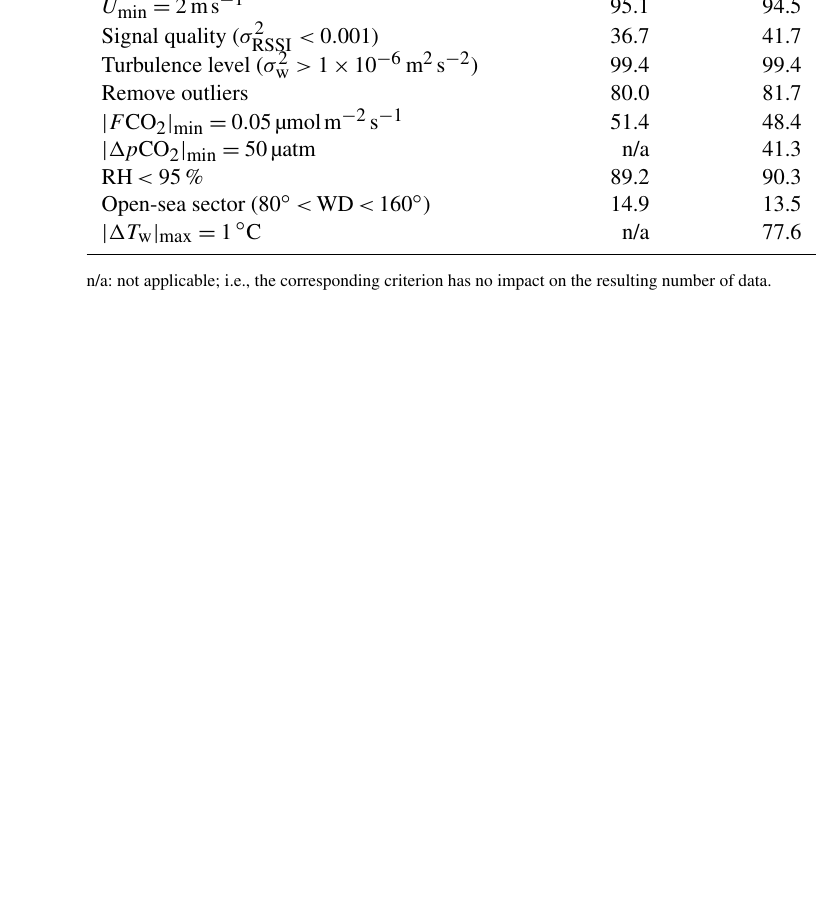
Table B1. Percentage of data that successfully fulfil each individual quality control criterion. The percentages are relative to the total recorded number of data (100% = 125001 for F CO 2 and 100% = 66475 for k 660 ). Quality control